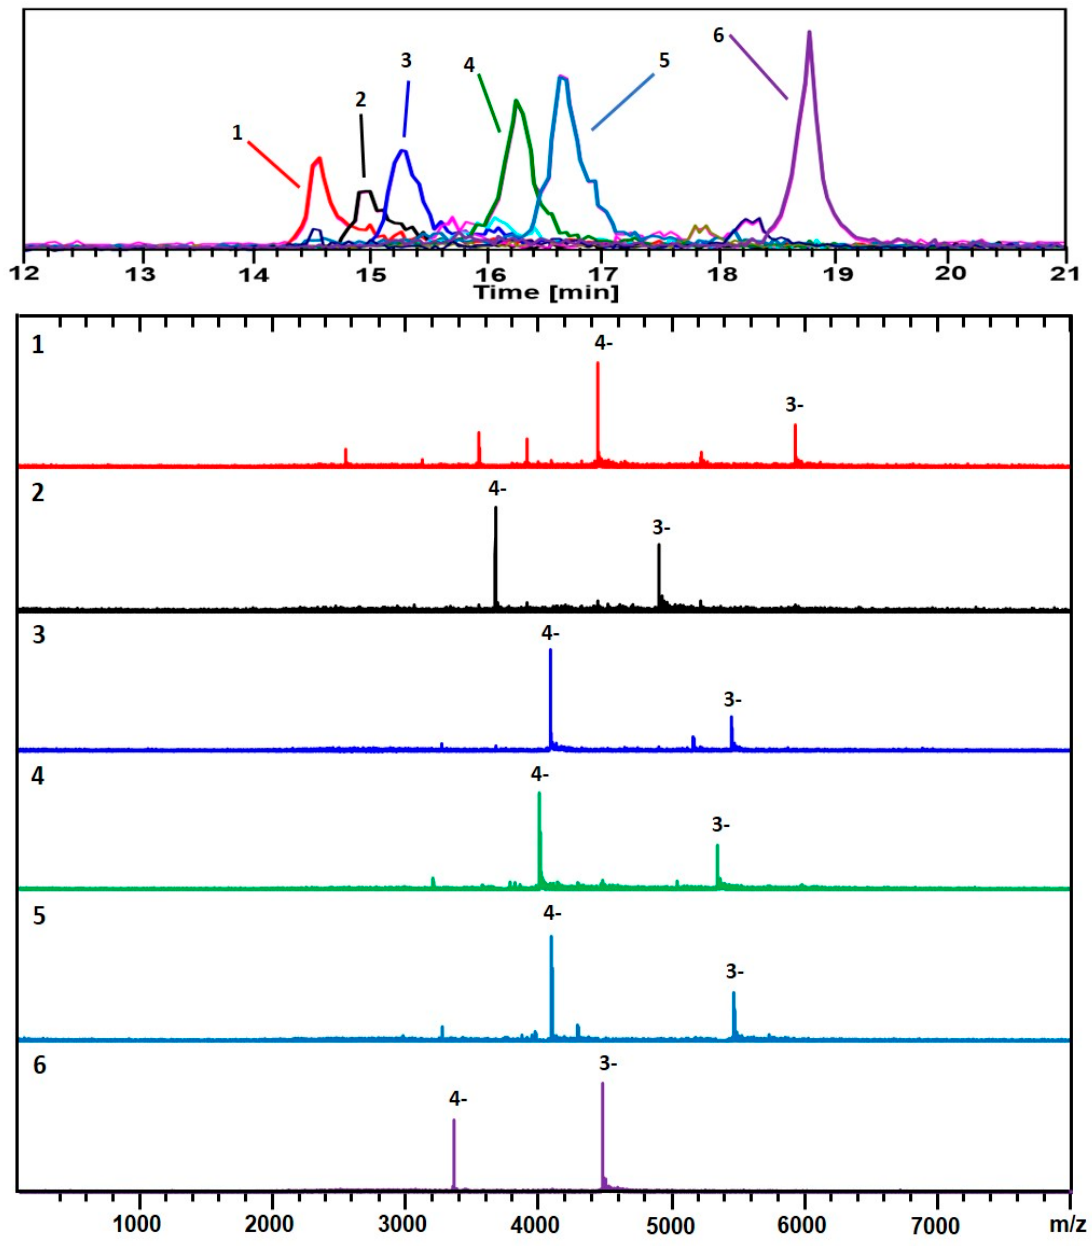
Figure 3. The analysis of a second preparation ( GPV ) of Au / 3-MBA clusters. Negative ionization mode (-ESI) detection shows mainly 3 − & 4 − charge-states. The black trace corresponds to the base peak chromatogram ( m / z 100–8,000). The color-coded EIC chromatographic peaks track with the coded and numbered mass spectra listed herein, with compositions assigned as follows: (1, Red) (67, 30), 17.8 kDa; (2, Black) (53, 28), 14.7 kDa; (3, Blue) (59, 31), 16.3 kDa; (4, Green) (58, 30), 16.0 kDa; (5, Light Blue) (60, 30), 16.4 kDa; and (6, Purple) (48, 26), 13.4 kDa. For the singly charged (z = 1 − ) of the same sample, see Figures S3 and S4. The polyacrylamide gel-electrophoresis (PAGE) analysis and corresponding HPLC-ESI-MS chromatogram are presented in Figure S4.